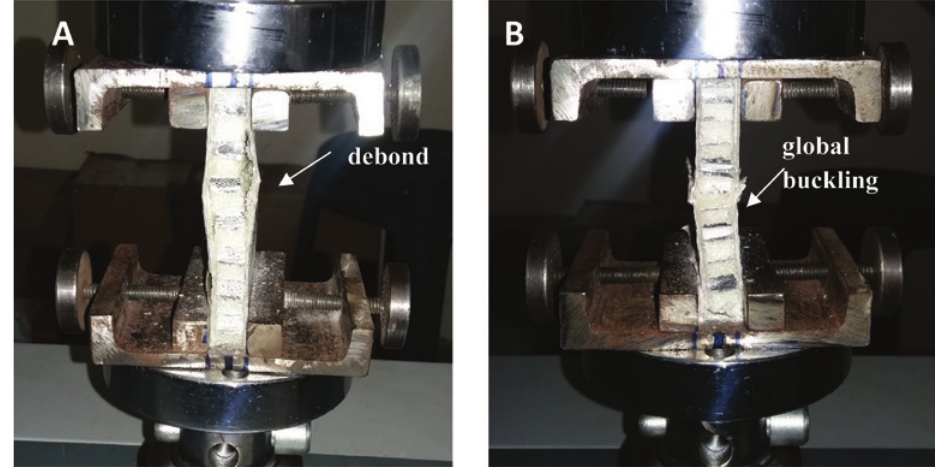
Figure 11: Details of the failure in specimens under edgewise compression (A) FHS panel, (B) PFHS panels.